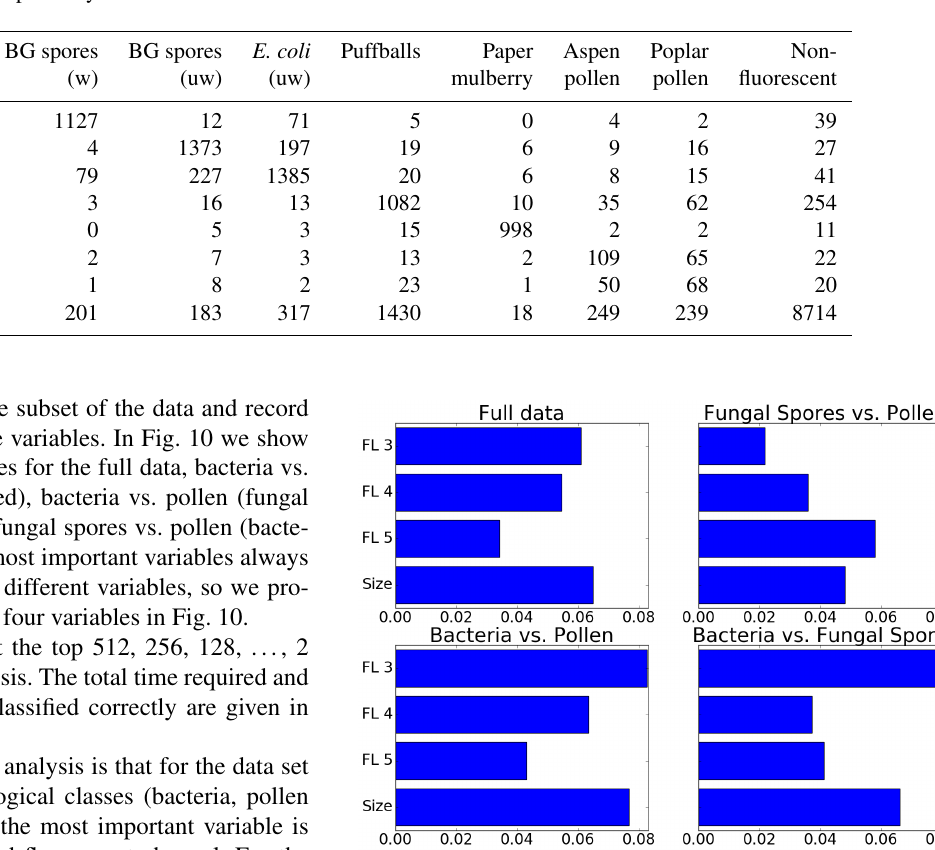
Table 5. Further breakdown of error for the gradient boosting algorithm on the full data set. The abbreviations (w) and (uw) are used for washed and unwashed samples respectively.